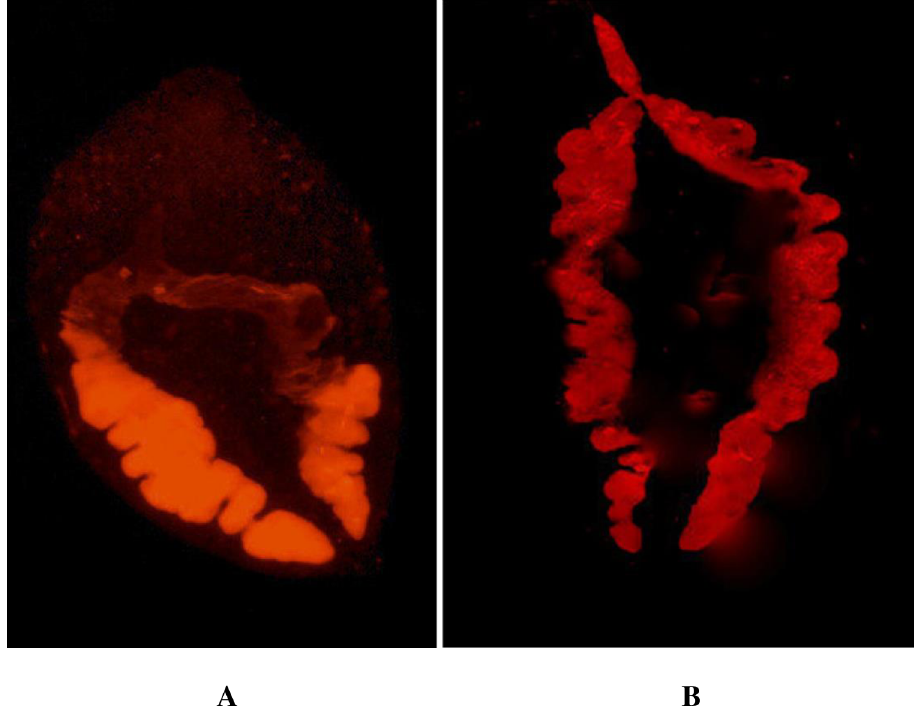
Fig 2. UV fluorescence microscopy of F . gigantica NEJs exposed to Cy 3 labelled long dsRNA and siRNA by soaking method. Figure shows uptake of long dsRNA (A) and siRNA (B) through the gut of the parasiteand both long and short dsRNA are widely diffused in parenchyma at 72 h (100 x magnifications).